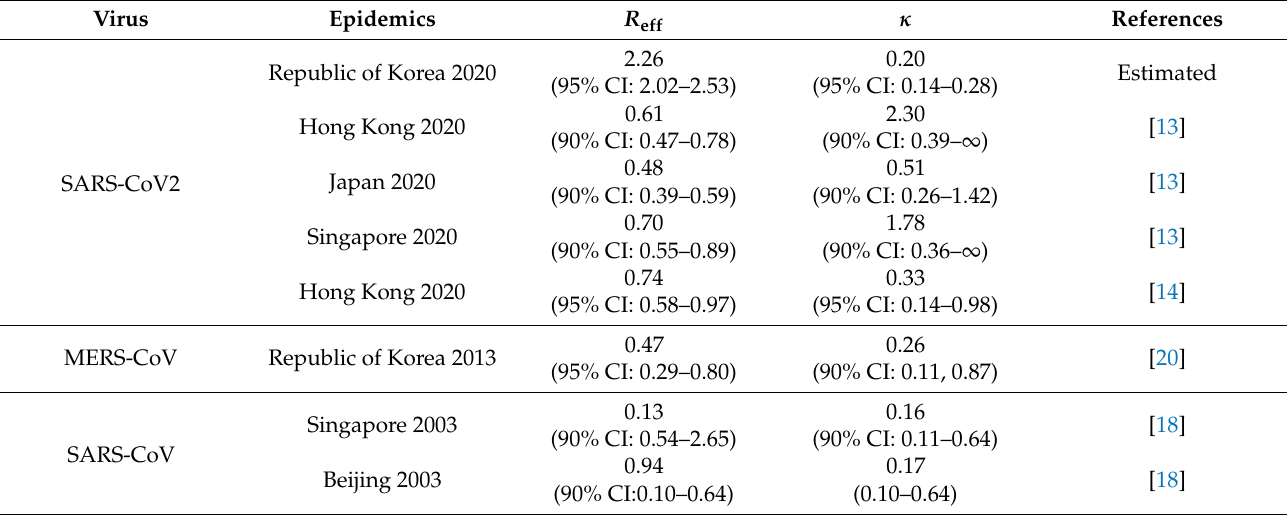
Table 3. Inference results for comparing the effective reproduction number and dispersion of COVID-19 in other countries or other